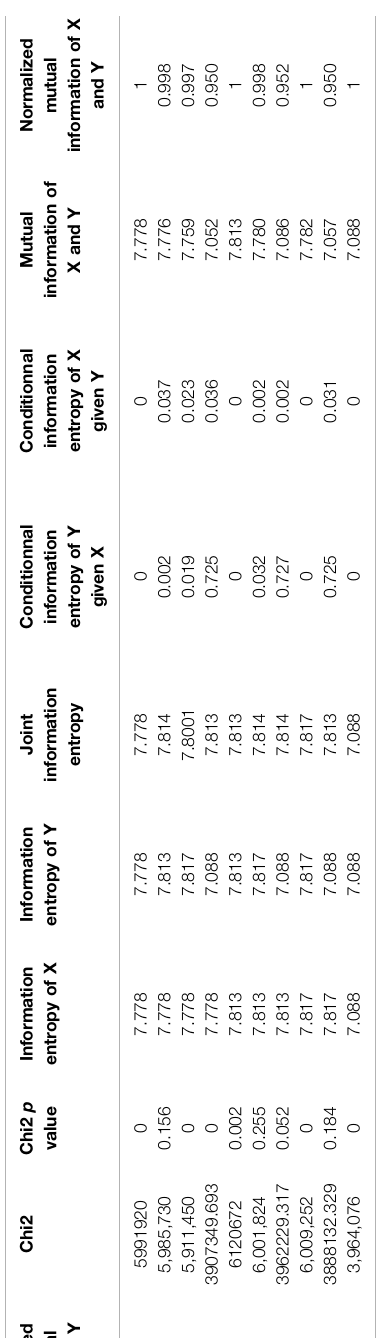
TABLE 2 | Pearson ’ s correlation coef fi cients and p -value for tweets and cryptocurrency price relationship. var1 Var2 Value_r